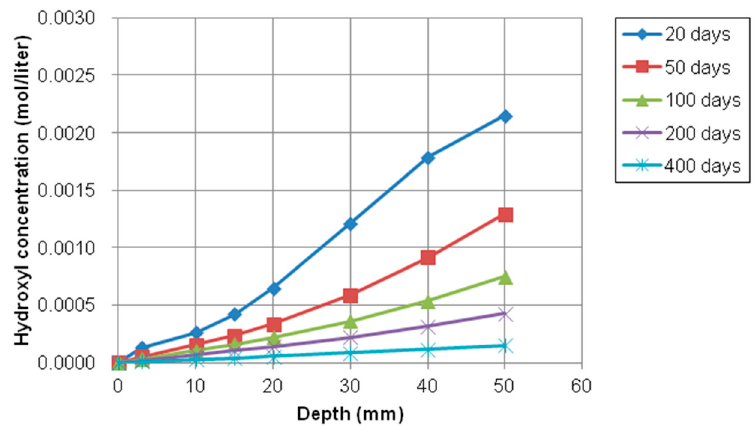
Figure 14. Profile of potassium concentration at different depth over time.